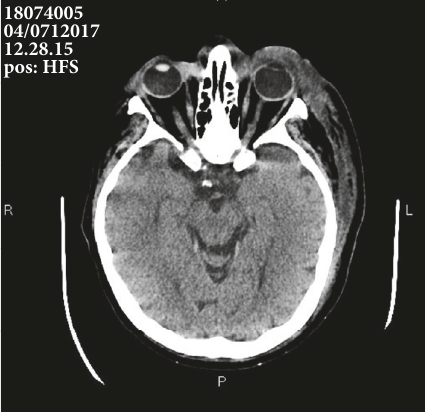
Figure 1: Computed tomography showing soft tissue